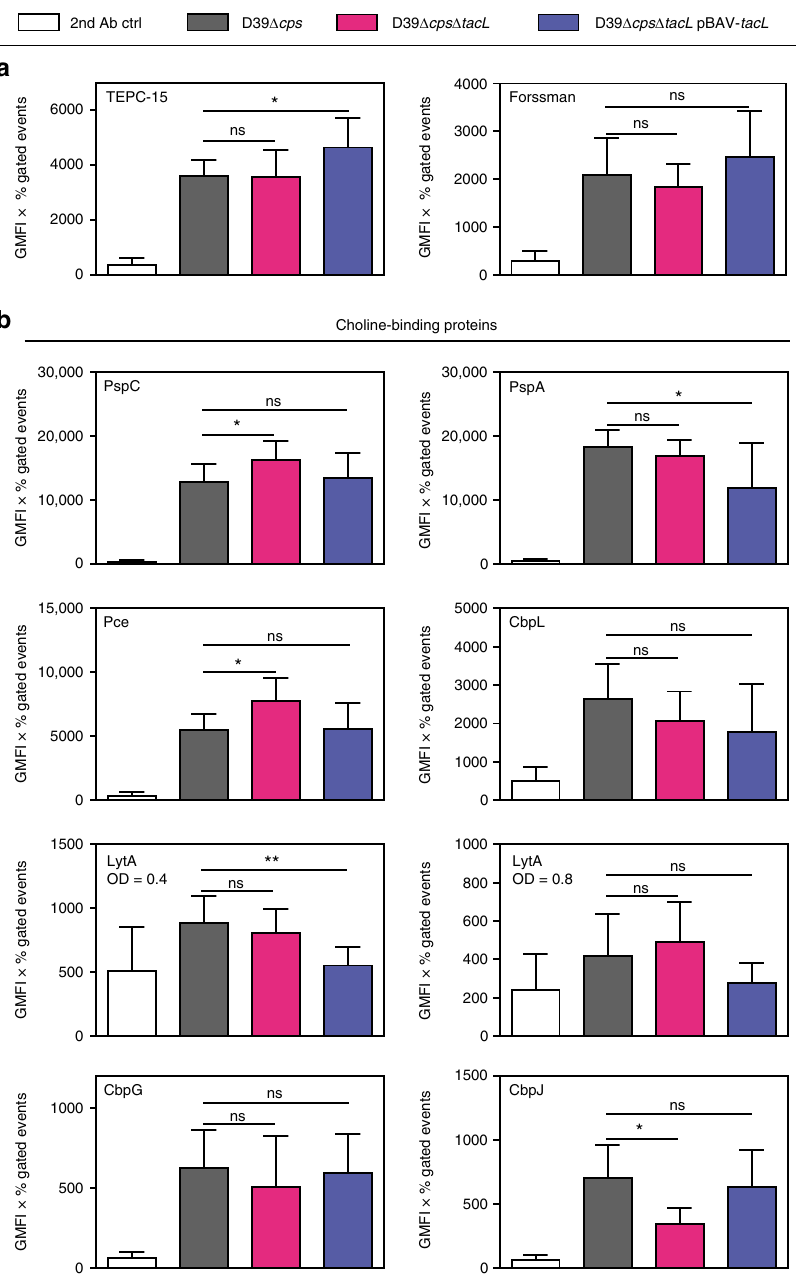
Fig. 4 Quantitative analysis of teichoic acids and choline-binding proteins. Bacteria were grown in THY medium to A 600 = 0.35 – 0.45 (for LytA 0.4 and 0.8), washed and incubated with antibodies. a The amount of P -Cho and the Forssman antigen of teichoic acids were determined using speci fi c primary antibodies (TEPC-15, anti-Forssman) and secondary Alexa 488 -labeled antibody in a fl ow cytometry-based assay. b Surface-associated CBPs were analyzed using speci fi c polyclonal mice IgG against the individual CBPs and secondary Alexa 488 -labeled antibodies in a fl ow cytometry-based assay (see also Supplementary Fig. 9 for representative histograms). The values are represented as the geometrical mean fl uorescence intensity multiplied with percent-gated events. Results are expressed as means ± s.d. (each experiment was performed at least three times). * p < 0.05; ns not signi fi cant (Student's unpaired t (Fig. 4a and Supplementary Fig. 9a). All strains contained a to be compensated either by a higher abundance of WTA on the similar amount of P -Cho. Unfortunately, pnTA-speci fi c anti- cell surface or by the accumulation of TA precursor chains. bodies are not currently available. For further quanti fi cation of the TAs, we made use of an anti-Forssman antibody that recognizes the terminal sugar residues ( α -D-Gal p NAc-(1 → 3)- β - D-Gal p NAc-(1 → )) of pnWTA and pnLTA 7 . Comparable amounts of the Forssman antigen were detected by fl ow cytometry in the tacL mutant, wild-type and complemented mutant. In summary, the loss of LTA in the tacL mutant appears